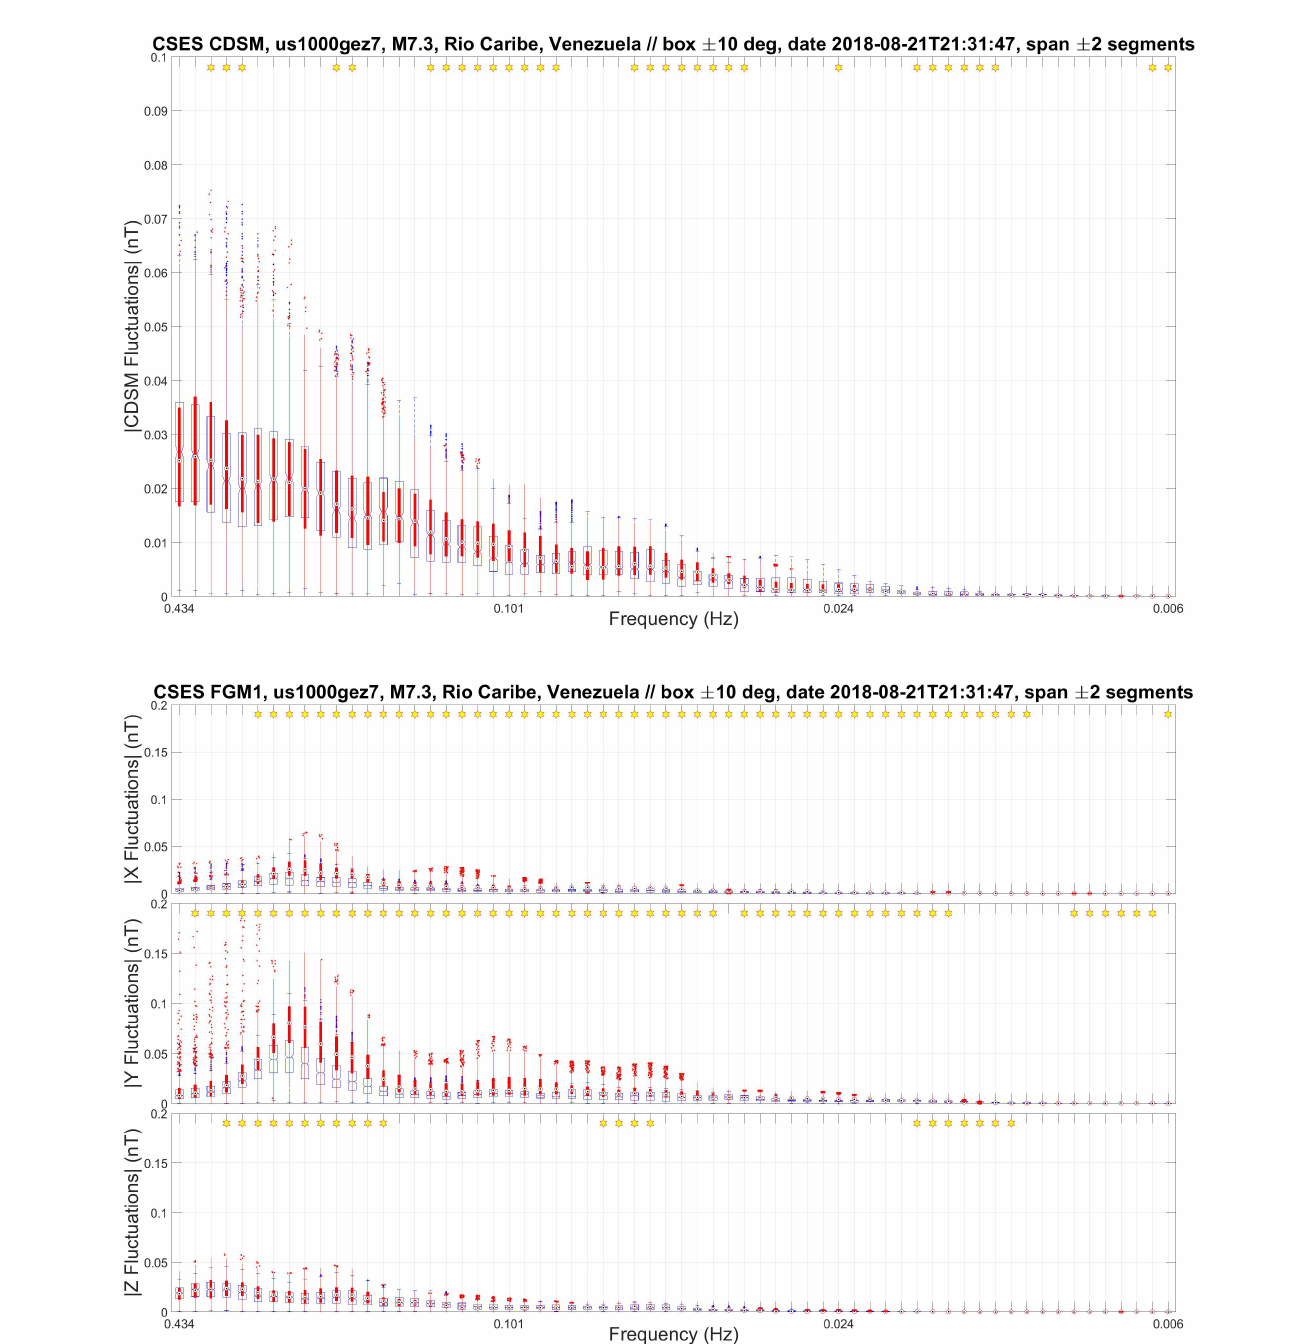
Figure 4. CSES investigation of the earthquake USGS event us1000gez7 with magnitude M7.3, Rio Caribe, Venezuela, focal depth 146.8 km, with a spatial dimension (box size) of ± 10 degrees. Top : Distribution of CSES CDSM magnetic field fluctuations grouped in individual frequency bands. The step size is in log-scale according to ln ( f n ) = − 0.7651–0.069315 × n, shown is the range n = {1 – 64}, i.e., the left box plot (n = 1) is f 1 = 0.4341 Hz (Nyquist frequency f s /2 = 1/2 Hz) and the right box plot (n = 64) is f 64 = 0.0055 Hz. Only satellite orbits during night times are considered. The time span around the EQ is ± 2 segments, i.e., in this case ∆ t = { − 2.61, − 1.62, − 0.64, 0.34, 1.33} days shift to the EQ at 2018-08-21T21:31:47. Bottom : Distribution of the CSES FGM1 magnetic field fluctuations after scalogram processing. The colour coding is the same as in Figure 2, the geomagnetic activity is | Dst | ≤ 20 nT for the selected time